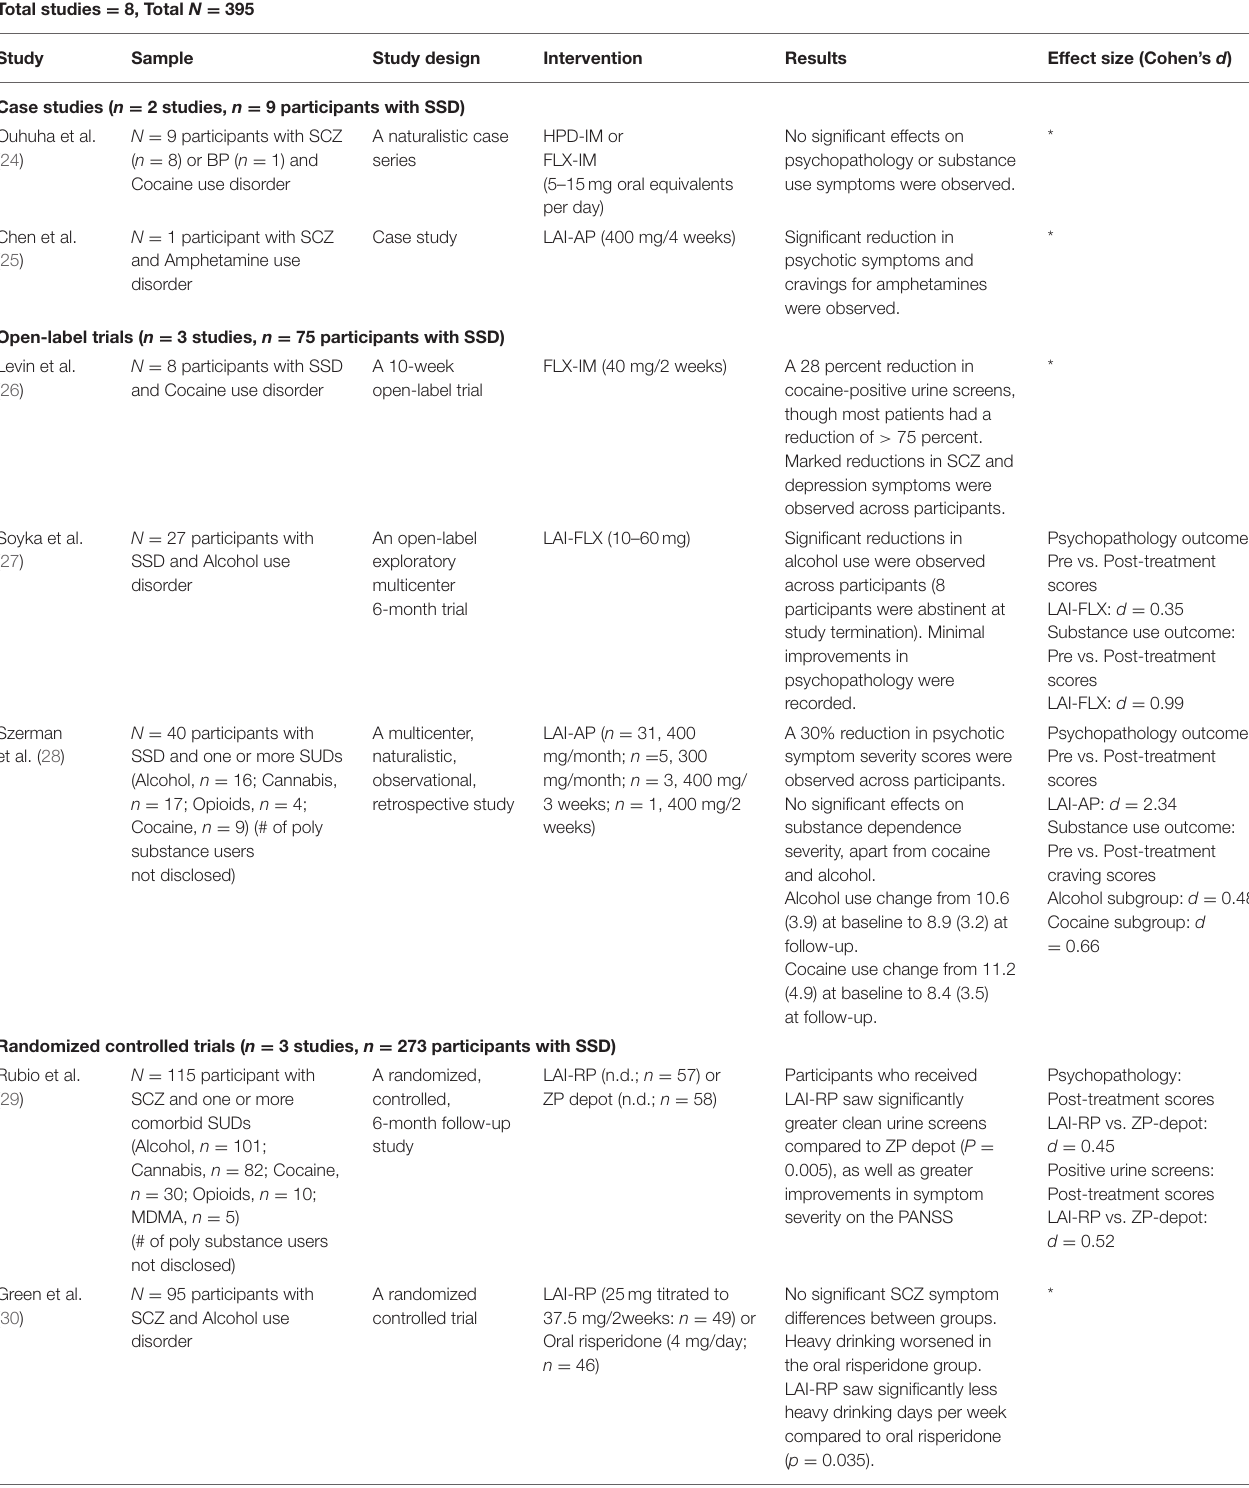
TABLE 1 | Long acting injectable antipsychotics for comorbid schizophrenia and substance use